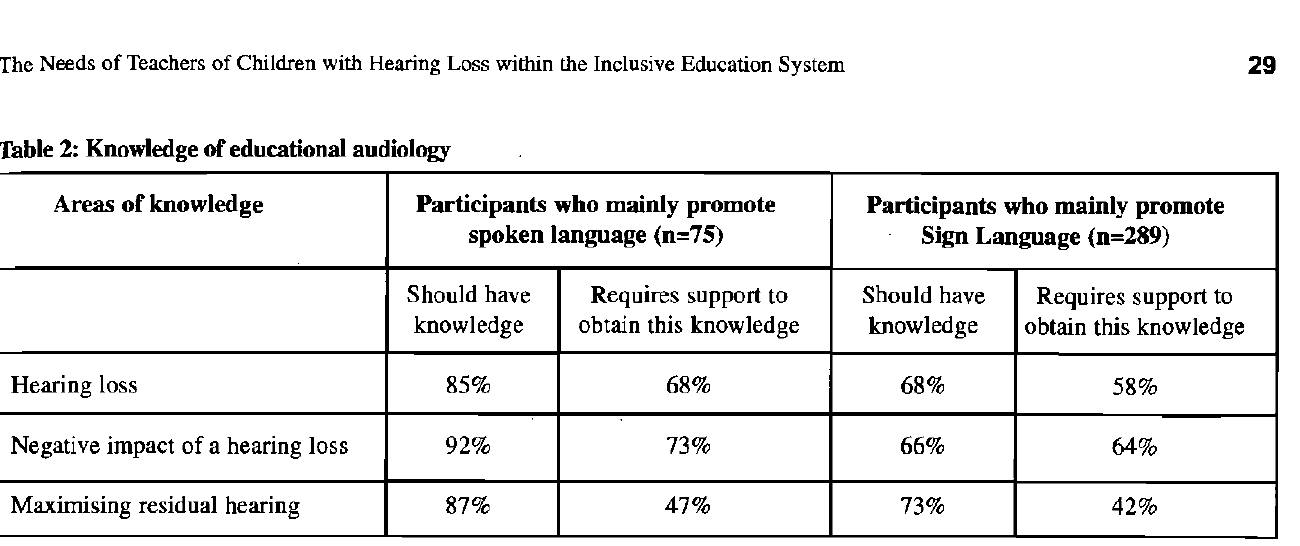
Table 2. Some excerpts from the focus group interviews are provided in the